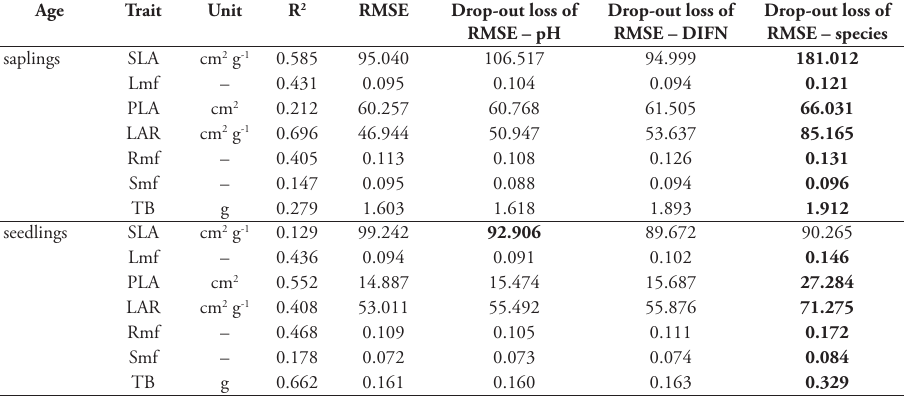
Table 1. Parameters of random forest models for traits and age classes and predictors importance ex- pressed by drop-out loss of RMSE. Abbreviations: SLA – specific leaf area, lmf – leaf mass fraction, PLA – projected leaf area, LAR – leaf area ratio, rmf – root mass fraction, smf – stem mass fraction, TB – total biomass. Bold value indicate predictor with the highest